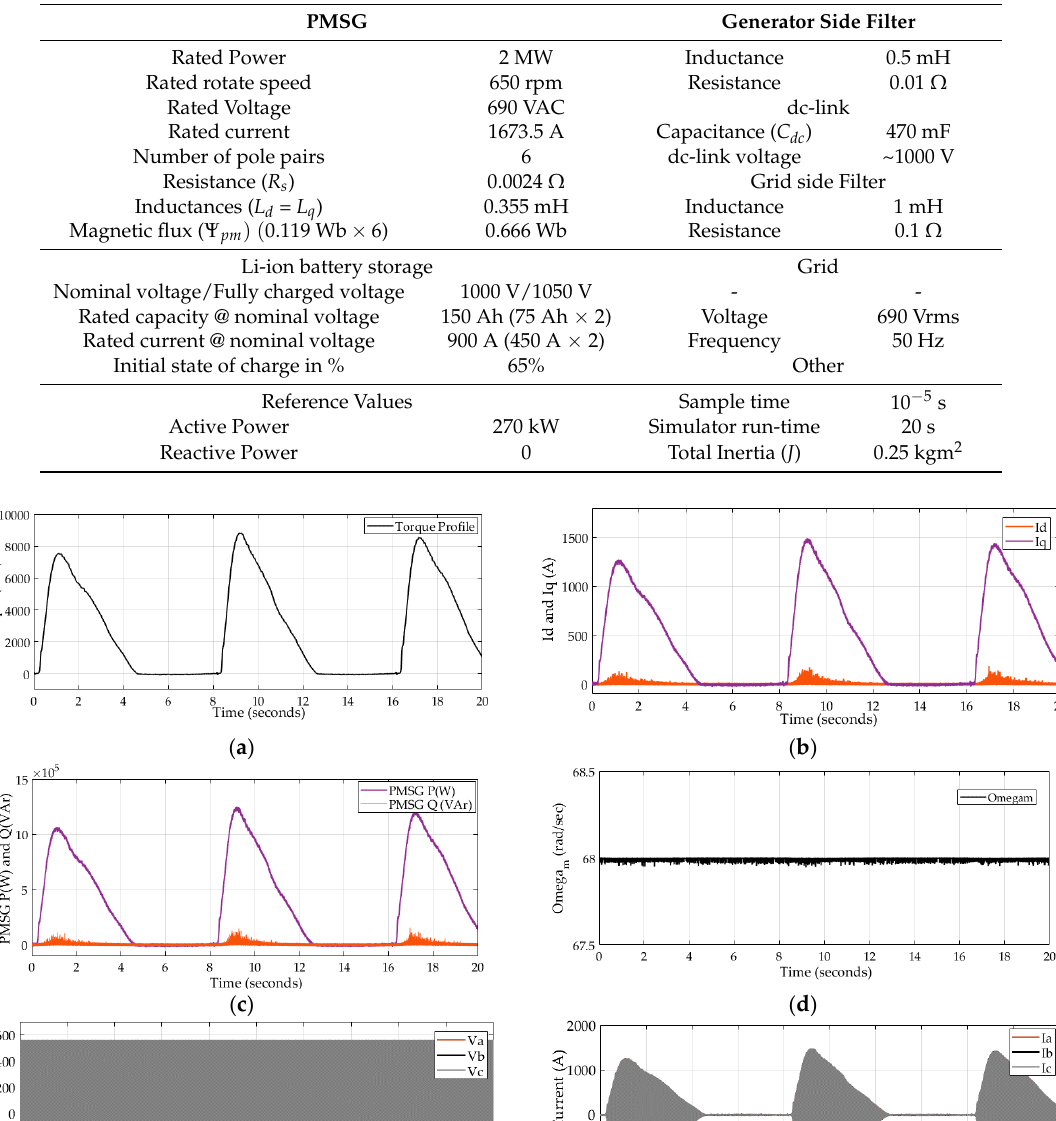
Table 2. System parameters used in the design.